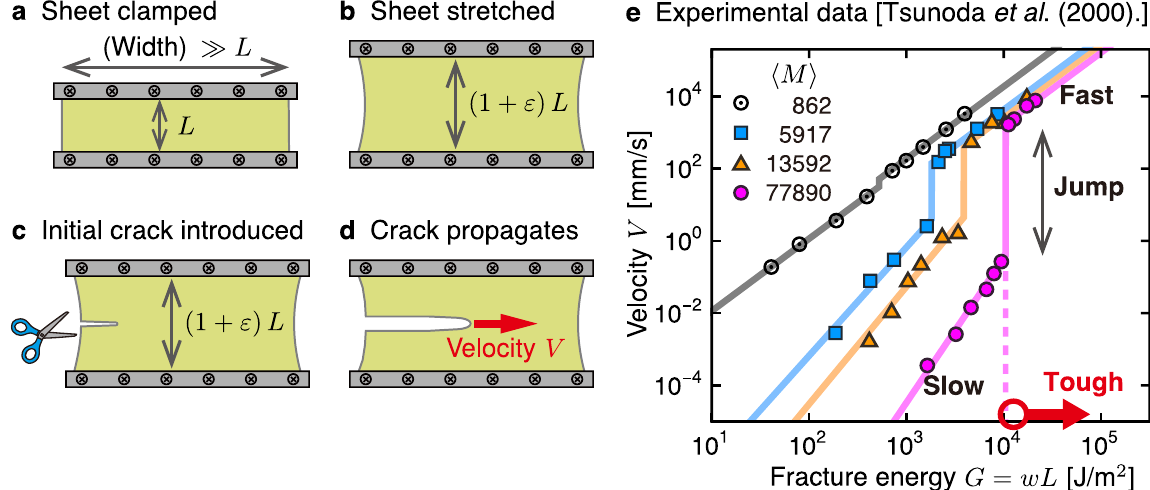
Figure 1. Velocity jump observed in the fixed-grip crack propagation. ( a – d ) Schematic illustrations of the fixed-grip crack propagation investigated in the present study. To achieve a constant-velocity crack propagation, we perform the following four steps: ( a ) we clamp the top and bottom edges of the sheet of height L ; ( b ) we stretch the sheet to a fixed strain ε ; ( c ) we introduce a small crack to initiate crack propagation; ( d ) after a short transient time, the crack propagates at a constant velocity V under the fixed strain ε . In the fixed-grip crack propagation, the fracture energy G and the energy release rate, which is expressed as wL under the fixed-grip condition, take the same value: G = wL . Here, w is the initially applied energy density. ( e ) Typical experimental results, G vs. V , obtained from the fixed-grip crack propagation by using elastomers filled with carbon black particles (taken from ref. 14). With increase in fracture energy, the slow-velocity regime (straight line on the low-velocity side) is terminated by an abrupt velocity jump, after which follows the fast-velocity regime (straight line on the high-velocity side). Here, 〈 M 〉 represent the average molar mass between nearest cross-links. In this series of experiments, a systematic increase in the cross-link distance leads to increase in the transition energy. Toughening is achieved by increasing the fracture energy at the transition